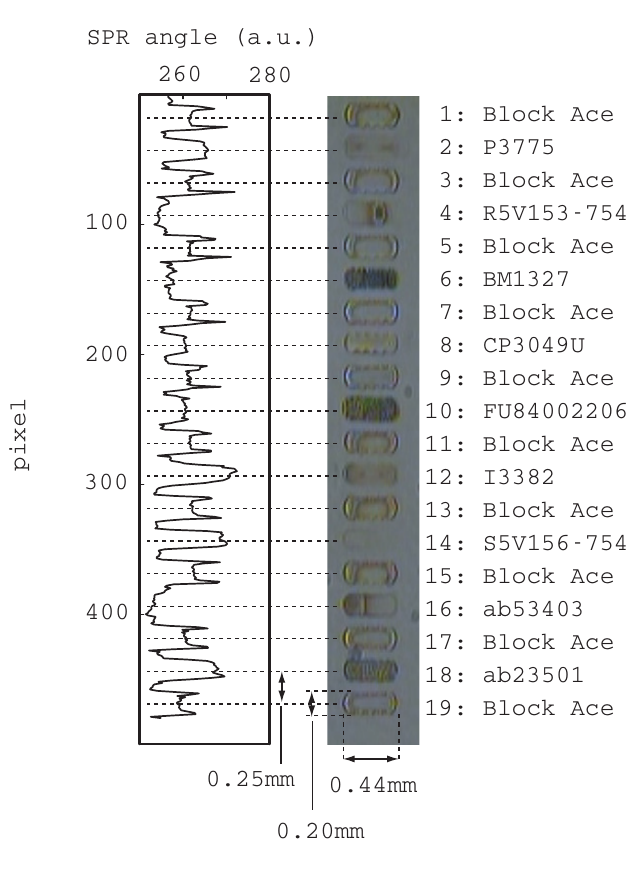
Figure 3. Photograph of spotted antibodies and enzyme in a band array structure ( center ), their abbreviations ( right ) and the SPR signal at the center of each band ( left ). The blocking reagent (Block Ace) was spotted on both sides of the antibodies and enzyme as a reference in difference